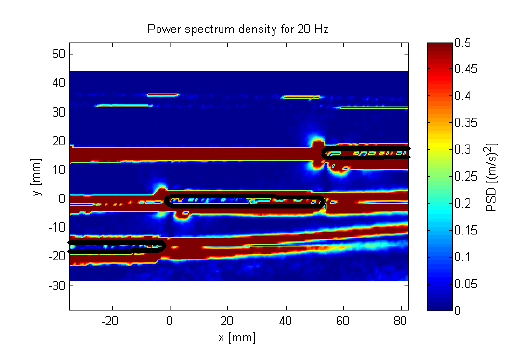
Fig. 7a. PSD scalar map for 20Hz, phase angle ϕ=0 .